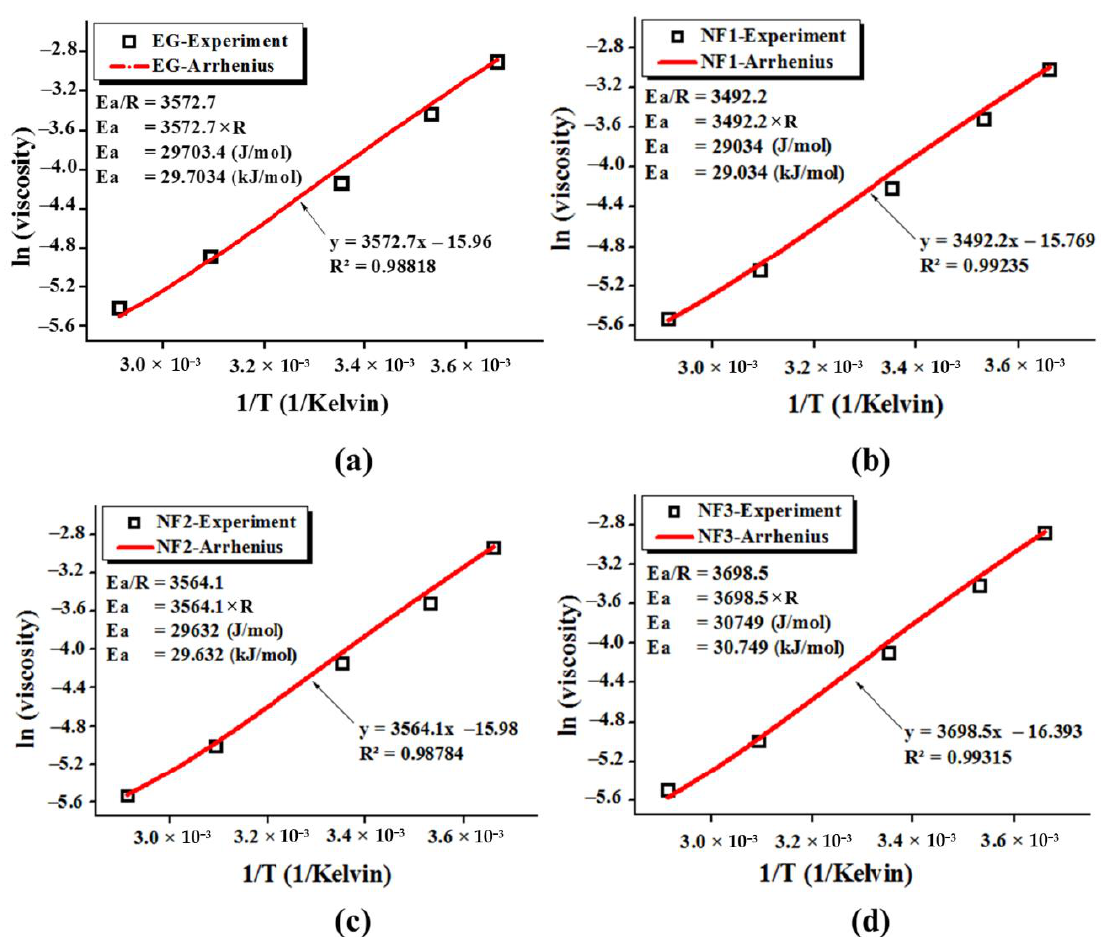
Figure 9. Relationship between the experimental and Arrhenius Equation (6) fitting for activation energy (Ea) estimation where viscosity is in Pa · s while the temperature is in Kelvin; ( a ) EG, ( b ) NF1, ( c ) NF2 and ( d ) NF3.